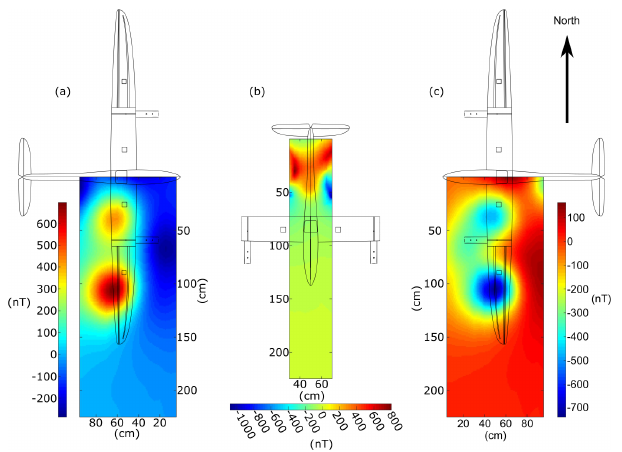
Figure 3. The diurnal-corrected and background-subtracted mag- netic signature: (a) the starboard wing, (b) the area along the longi- tudinal axis of the UAV, and (c) the port wing.